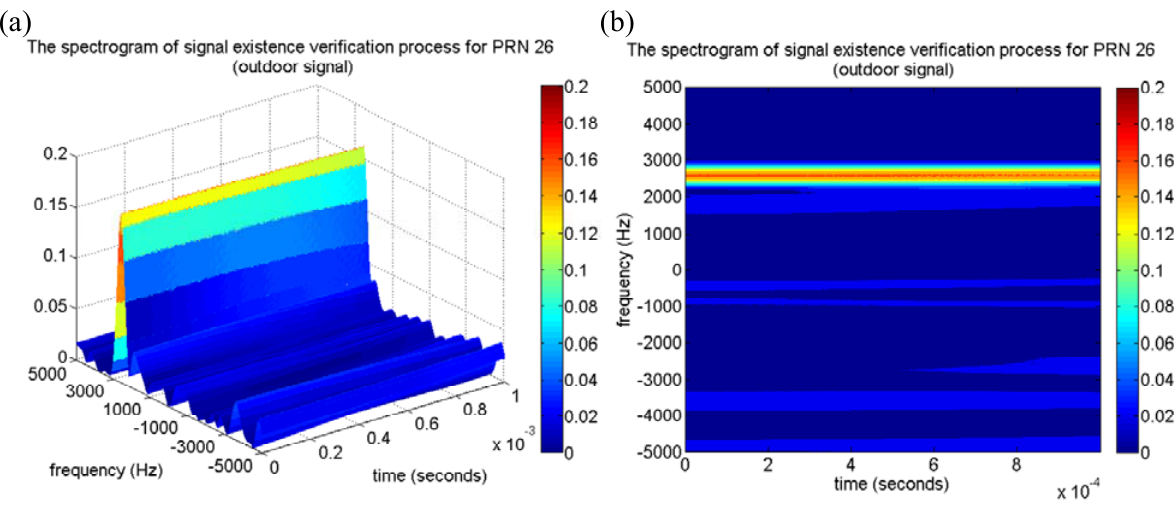
Figure 9. (a) The spectrogram of the signal existence verification (SEV) process for PRN 26 satellite signal. (b) The top view of (a), a characteristic sinusoid wave can be observed around the frequency of 2,500